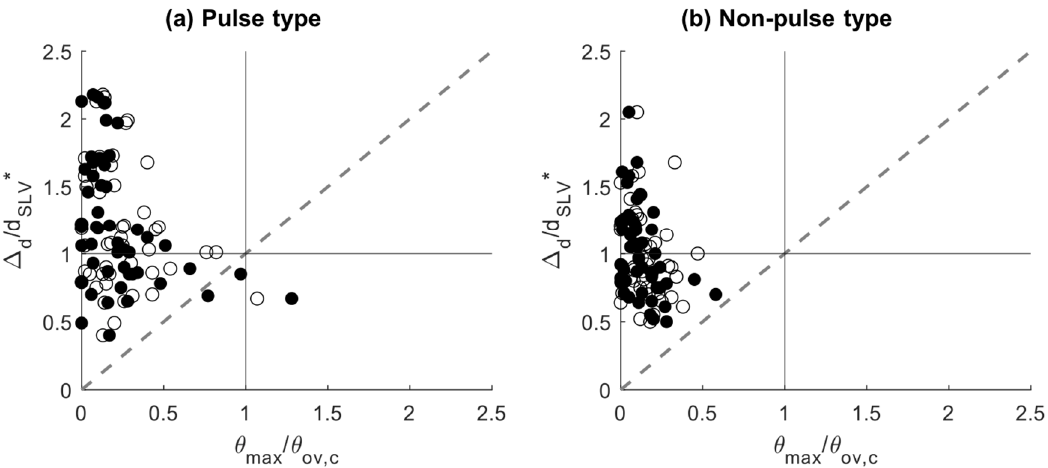
Figure 19. Church. Comparison of the code-based (equivalent static) and rocking (non-linear dynamic) demand-capacity